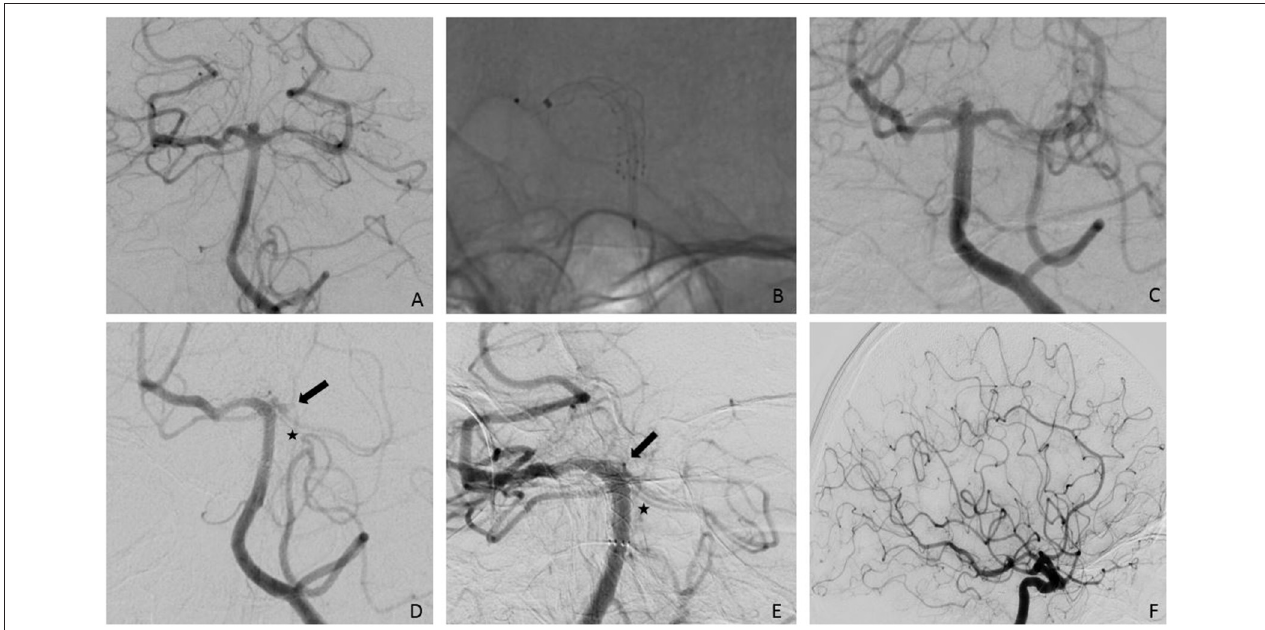
FIGURE 3 | (A) Posterior-anterior view after injection of the left VA showing a 2.5mm aneurysm of the basilar bifurcation, slightly more to the right side; (B) successful implantation of a p64 3/15mm from the right PCA to the BA; (C) final run after the FD implantation.; (D) first FU after four months shows a small aneurysm remnant as well as a significant caliber reduction of the left P1- segment (arrow). The SCAs on the left side remain the same (asterisk); (E) . second FU after nine months shows complete occlusion of the aneurysm as well as the left P1-segment; (F) . injection of the left ICA confirms supply of the left PCA via PcomA. pa, posterior-anterior; VA, vertebral artery; PCA, posterior cerebral artery; BA, basilar artery; FD, flow diverter; SCA, superior cerebellar artery; ICA, internal carotid artery; PcomA, posterior communicating